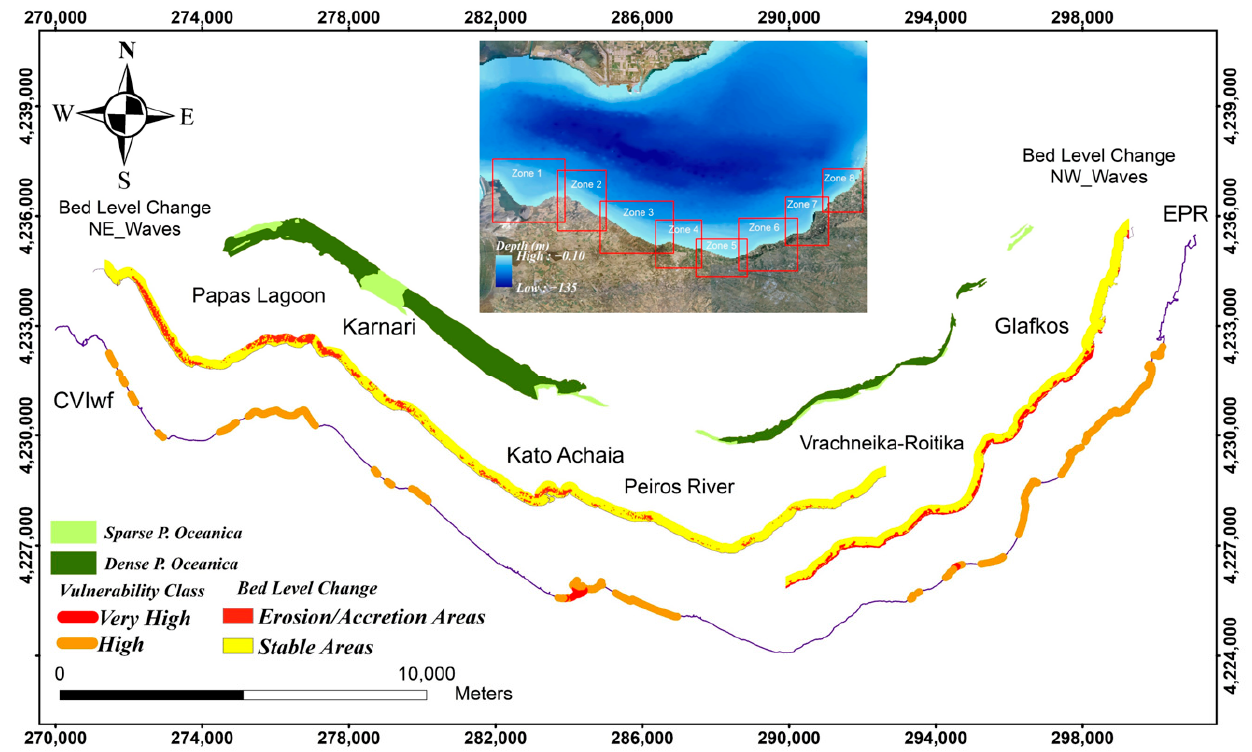
Figure 17. Spatial distribution of high and very high vulnerability classes using CVI WF compared with the rate of bed level change (mostly affected by NE winds in the west and NW waves in the east) and the P. oceanica spatial distribution along the coastline of the study area.